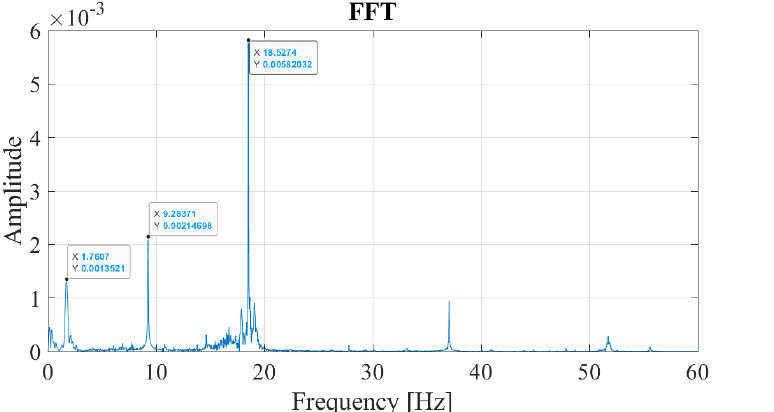
Figure 11. FAS of the accelerations recorded on the bogie ignoring track irregularities. Although the frequencies associated with the bridge and the train/track can be distin- guished from the FAS plotted in Figure 11 when the train-track geometry and the speed of the train is known a priori as in the case of a numerical model, the FAS itself does not provide enough information to distinguish the bridge frequencies from the others when the track geometry and the train speed is unknown. The main reason for this is the fact that the Fourier Amplitude Spectrum is valid for the entire time history. On the other hand, the vibrations associated with the frequency of the bridge are expected to occur only while the sensor is traversing the bridge whereas the vibrations associated with the train-track system should be visible during the entire motion of the train including the front and back approaches. However, Fourier amplitude spectrum does not any provide any information on the time evolution of the frequency content of the vibrations. To overcome this shortcoming, Continuous Wavelet Transform of the acceleration signal recorded at the bogie using Morlet wavelet is computed and the wavelet coefficient map of the signal is plotted in Figure 12. The wavelet coefficient map shows that the high frequency vibrations indicated by scales lower than 20 in Figure 12 has a relatively evenly distributed energy content throughout the entire time history. On the other hand, the vibrations associated with lower frequencies (i.e., higher scales in Figure 12) are only prominent while the sensor is crossing the bridge. From this, it can be deducted that the lower frequencies prominent in